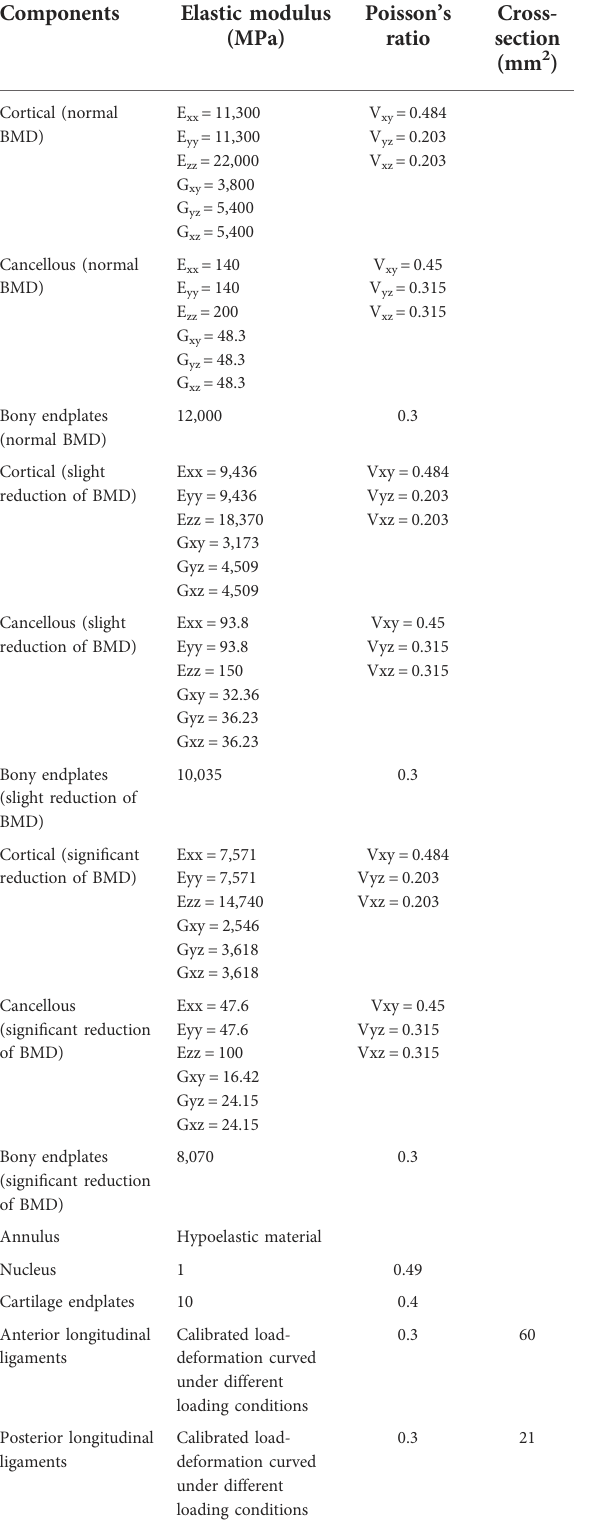
TABLE 1 Material properties of FE models ’